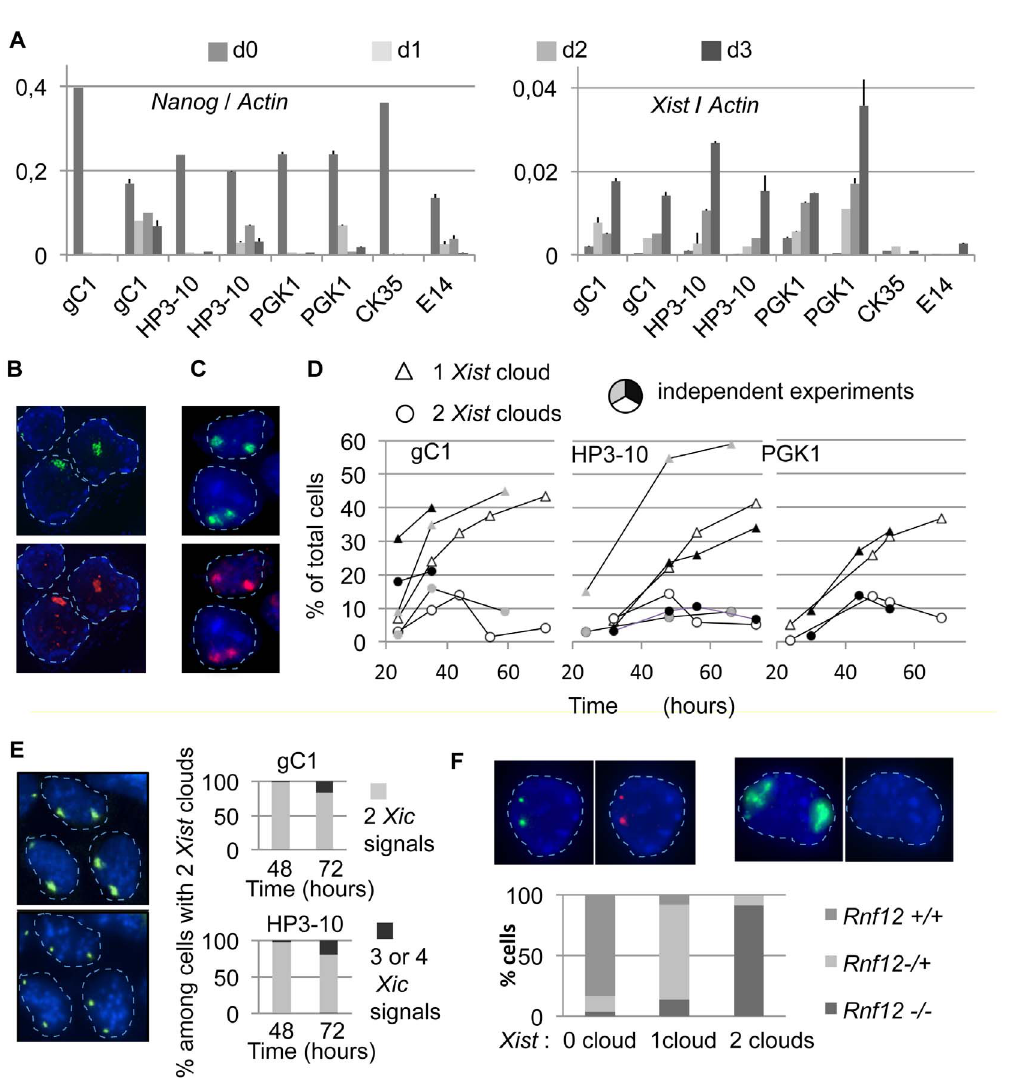
Fig.1.InitiationofXchromosomeinactivationcanoccuronbothXsinthecourseofdifferentiationofnaiveEScells. A)KineticanalysisusingquantitativeRT- PCR of the expression levels of Nanog and Xist normalized to Actin levels in the course of three days of differentiation of ES cells. Wild-type female cell lines: gC1, HP3-10 and PGK1. Control wild-type male cell lines: CK35 and E14Tg2A. RT- controls required at least 10 cycles more than the RT + samples in order to exceed threshold. Columns represent the ratio of the means of triplicate measurement of 2 -ct for Nanog , Xist and Actin at each timepoint in each differentiation experiment. Errorbarsrepresentstandarddeviationoftheratiosof Xist (or Nanog )to Actin calculatedas:sdof Xist / Actin 5 (meanof Xist / Actin )x[(sdof Xist /meanof Xist ) 2 + (sdof Actin /mean of Actin ) 2 ] 0,5 . Two fully independent differentiation experiments performed on separate days with each female ES cell line are shown. B) Immuno-RNA- FISH of Xist and H3-K27me3 using the HP3-10 cell line differentiated for 3 days: Xist RNA clouds (green, top panel) correspond to domains of enrichment for H3- K27me3(red, bottom panel). In B, C, E, and F, DAPI blue staining was digitally dampened to favor visualizationof the other channels. Nuclei arecircled with adashed line. C) Immuno-RNA-FISH of Xist and H3-K27me3 using the gC1 cell line differentiated for 36 hours. Nuclei showing two Xist clouds (green, top panel) additionally show two domains of enrichment for the H3-K27me3 mark (red, bottom panel). D) Kinetic analysis using Xist RNA-FISH. Cells showing one or two Xist clouds